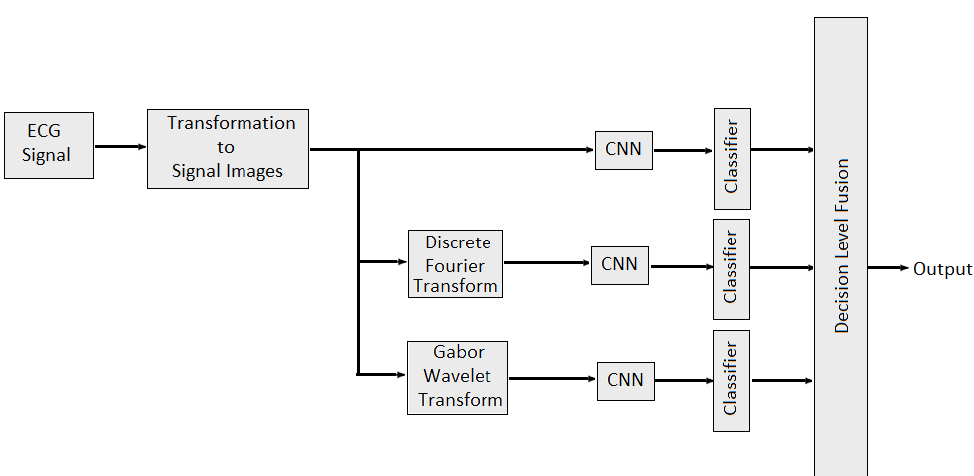
Figure 12. Multimodal Multidomain Fusion of ECG